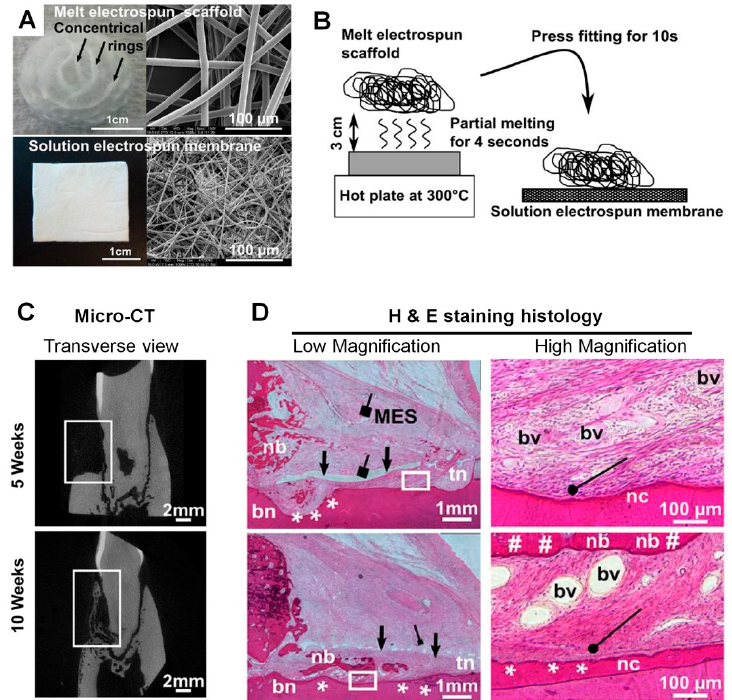
Figure 4. Multipahsic nanofibrous scaffold fabrication. Both polymer solution electrospinning and